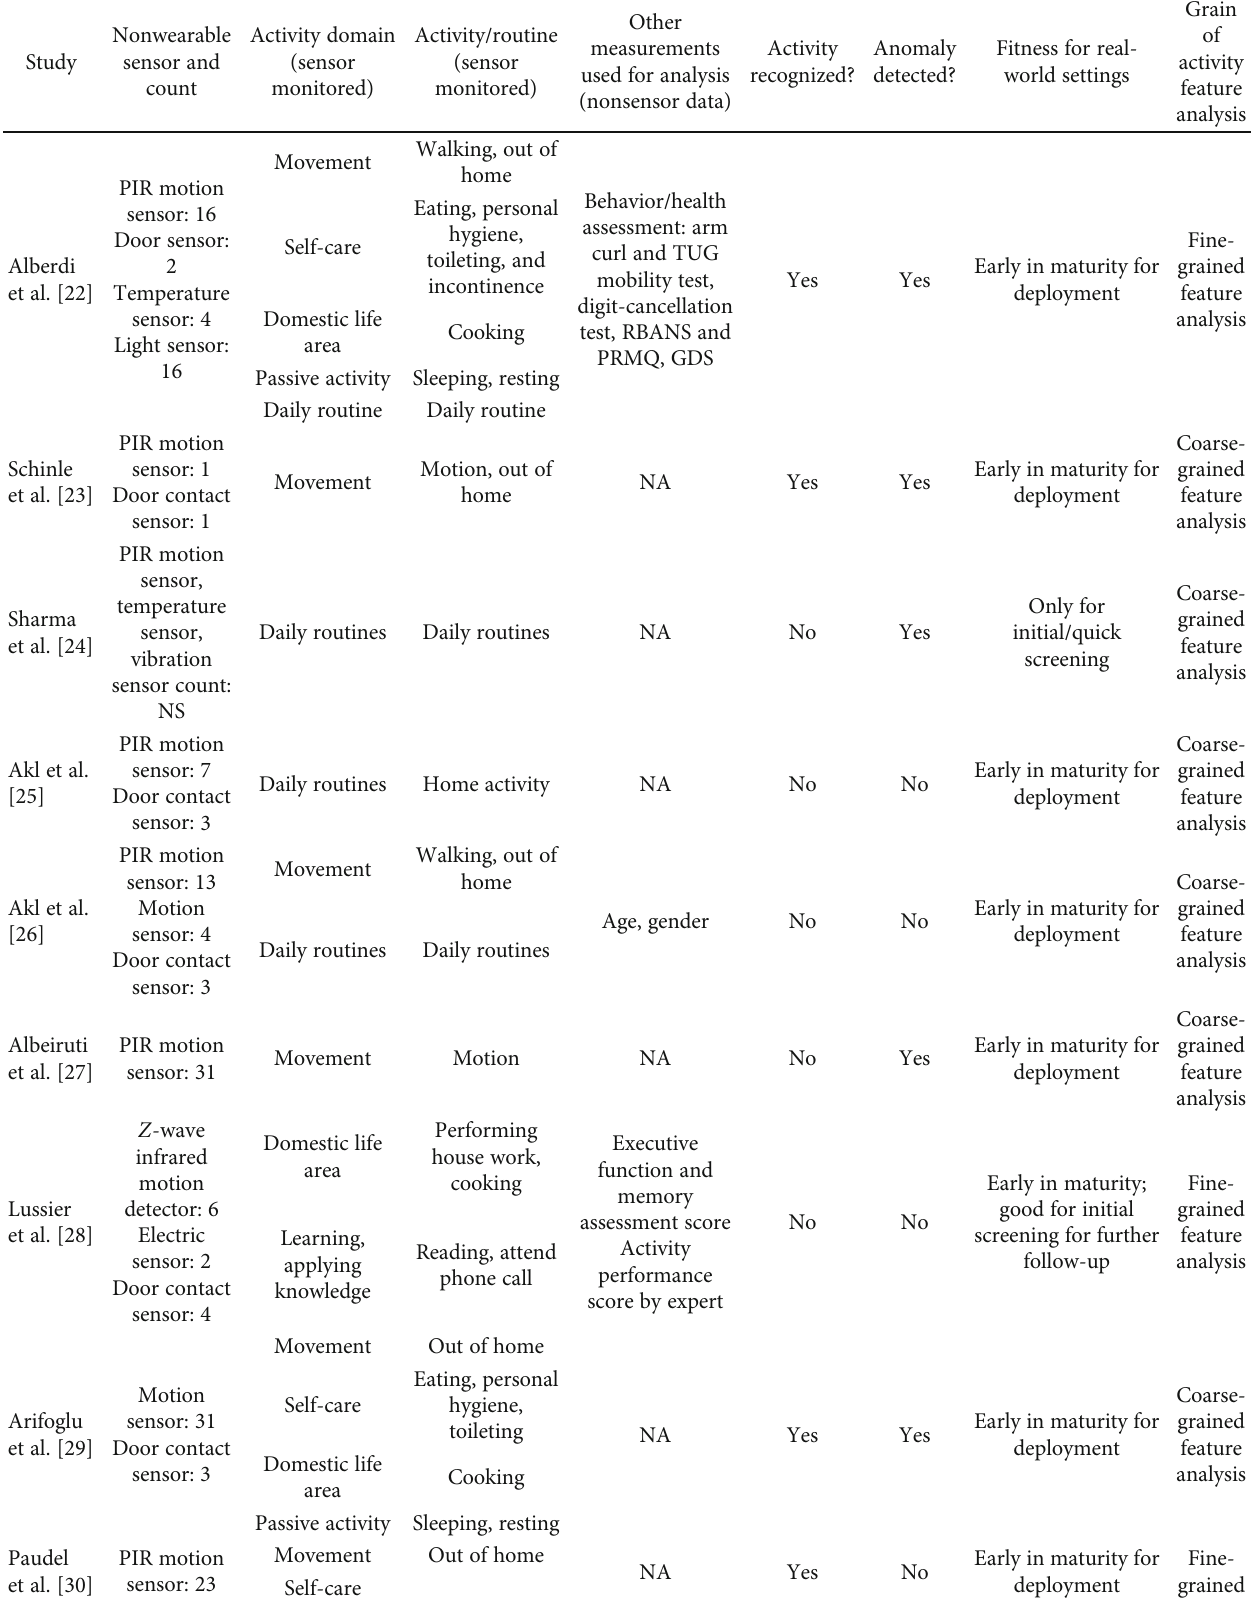
Table 3: Characteristics of sensor monitoring